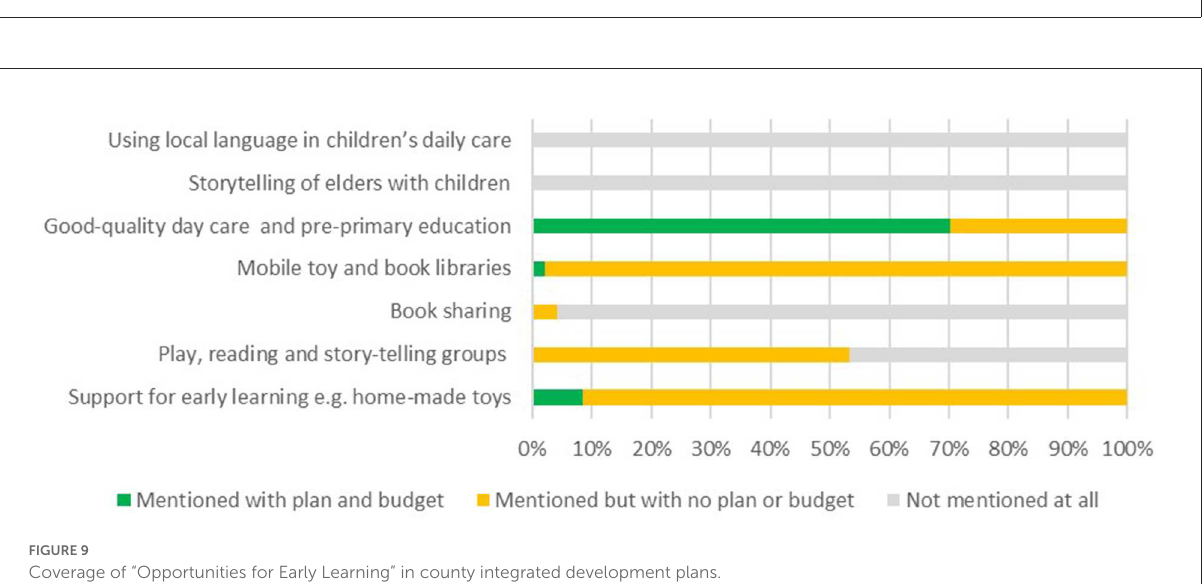
FIGURE9 Coverage of “Opportunities for Early Learning” in county integrated development